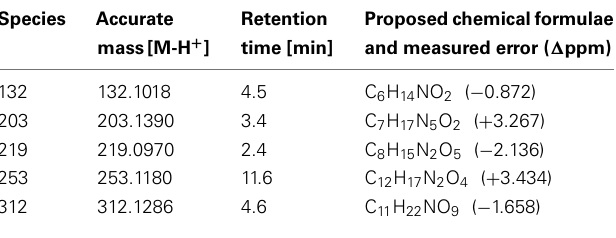
Table 1 |Accurate mass determination for all five significant species in xylem sap after arsenate challenge.